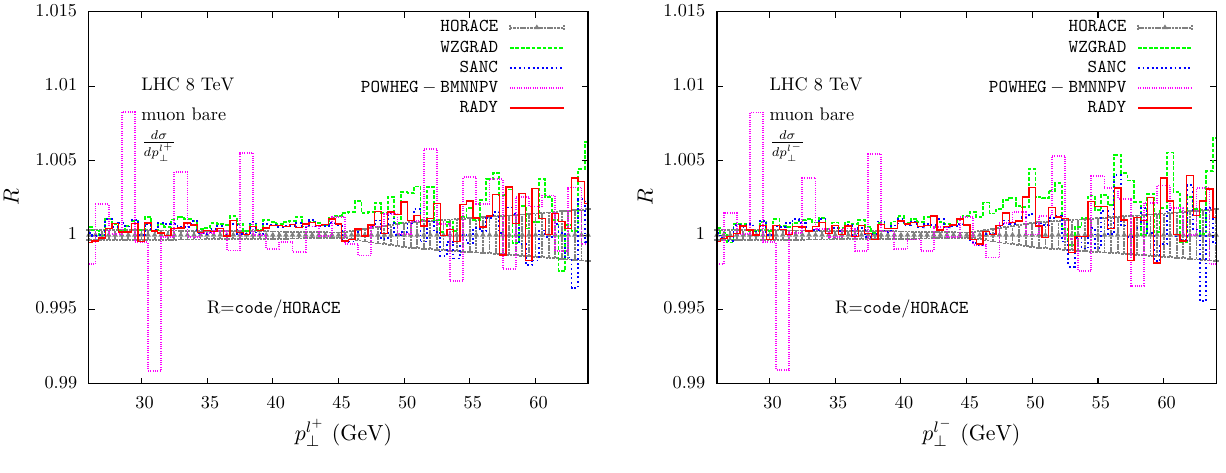
Fig. 12 Tunedcomparisonofthe μ + and μ − transversemomentumdistributionsin pp → γ, Z → μ + μ − + X atthe8TeVLHCwithATLAS/CMS cuts in the bare setup, including NLO EW corrections